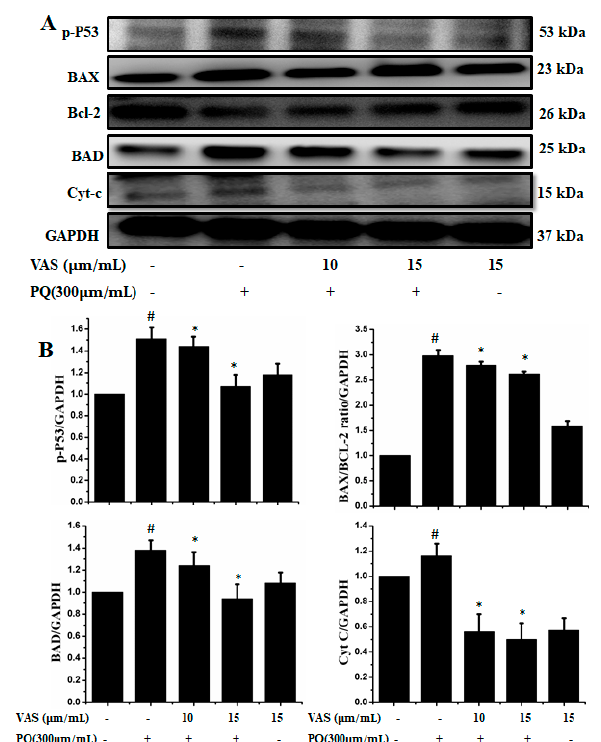
Figure 5. Vasicinone attenuated the paraquat-induced expression of apoptotic proteins in SH-SY5Y cells. ( A ) Cells were pretreated with vasicinone for 24 h, and paraquat was added for an additional 24 h. Total cell lysates were prepared for Western blotting analysis to determine apoptotic protein expression levels. GAPDH was used as an internal standard protein. ( B ) p53, Bax, Bad, Bcl-2 and cytochrome c release were determined by densitometry of the bands intensity. Three independent experiments were performed for this assay. Results are shown as the mean ± SD. # p < 0.01, compared with control cells; * p < 0.01, compared with paraquat-treated